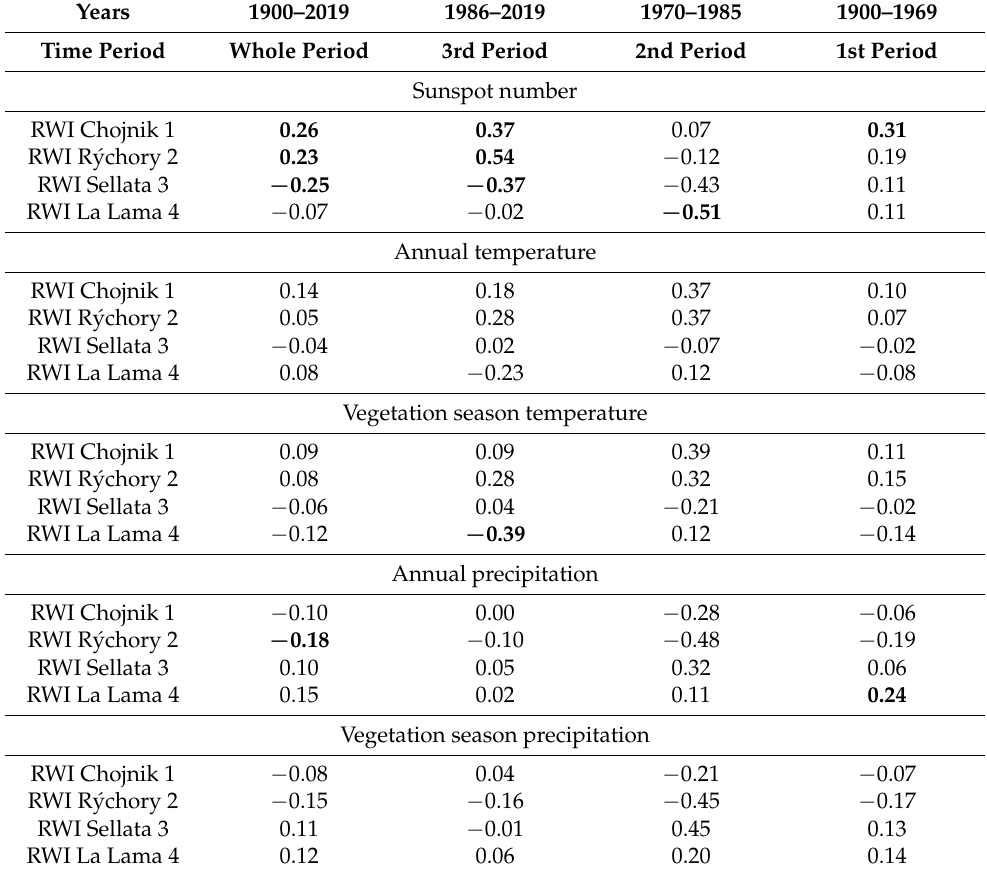
Table 3. Correlation coefficients for the tree-ring width index (RWI) of research plots in different time periods to the sunspot number, annual temperature, vegetation season temperature, annual precipitation and vegetation season precipitation. Significant correlation values are in bold; the correlations are significant at p <